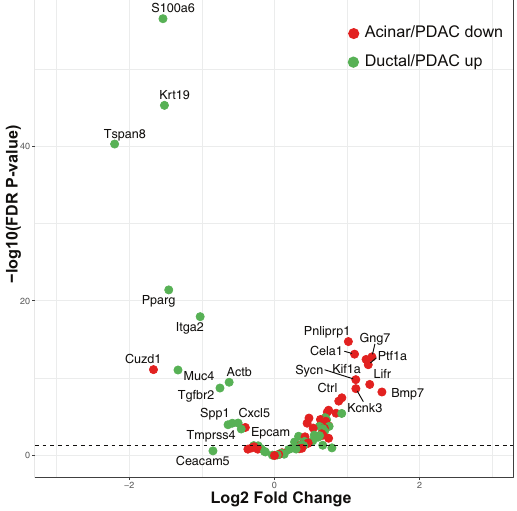
Fig. 8 Volcano plot of differentially expressed genes from TSA- induced ADM reversal in KC mouse acini. KC mouse pancreatic acini underwent ADM over 2 days of culture and were then exposed to 500nM of TSA for 2 additional days. RNA isolated from the treated